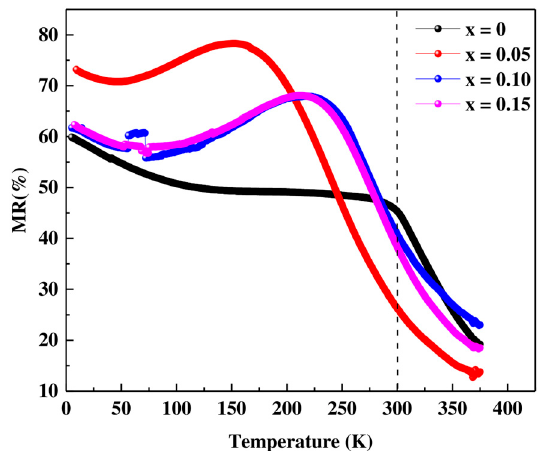
Figure 12. Variation of Magnetoresistance (%MR) vs. T, at different Co contents for Pr 0.7 Sr 0.3 Mn ( 1 − x ) Co x O 3 .